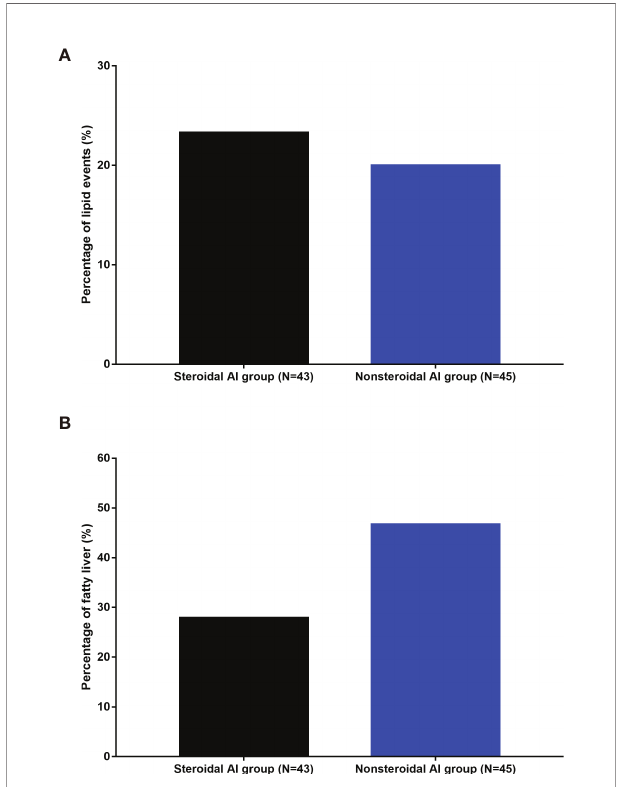
FIGURE 2 | Incidence of lipid events (A) and fatty liver (B) in different AI groups. AI, aromatase inhibitor.